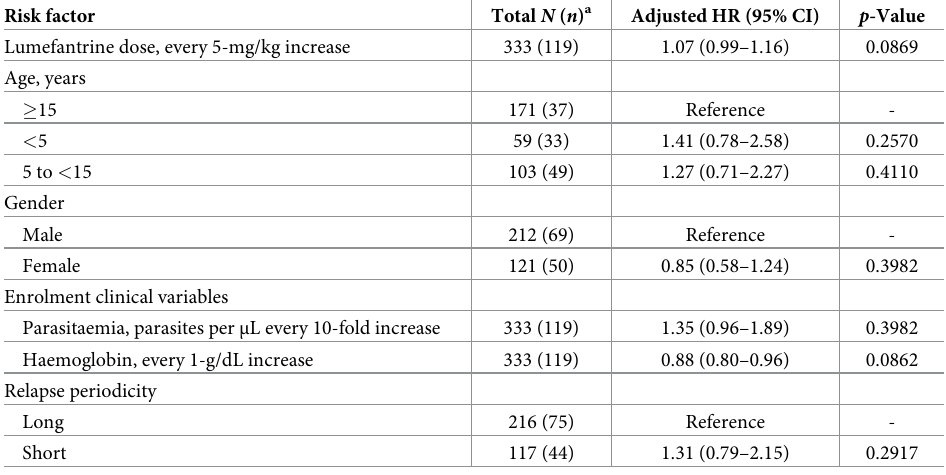
Table 3. Risk factors for P . vivax recurrence between days 7 and 42 in patients treated with artemether-lumefan- trine alone. Risk